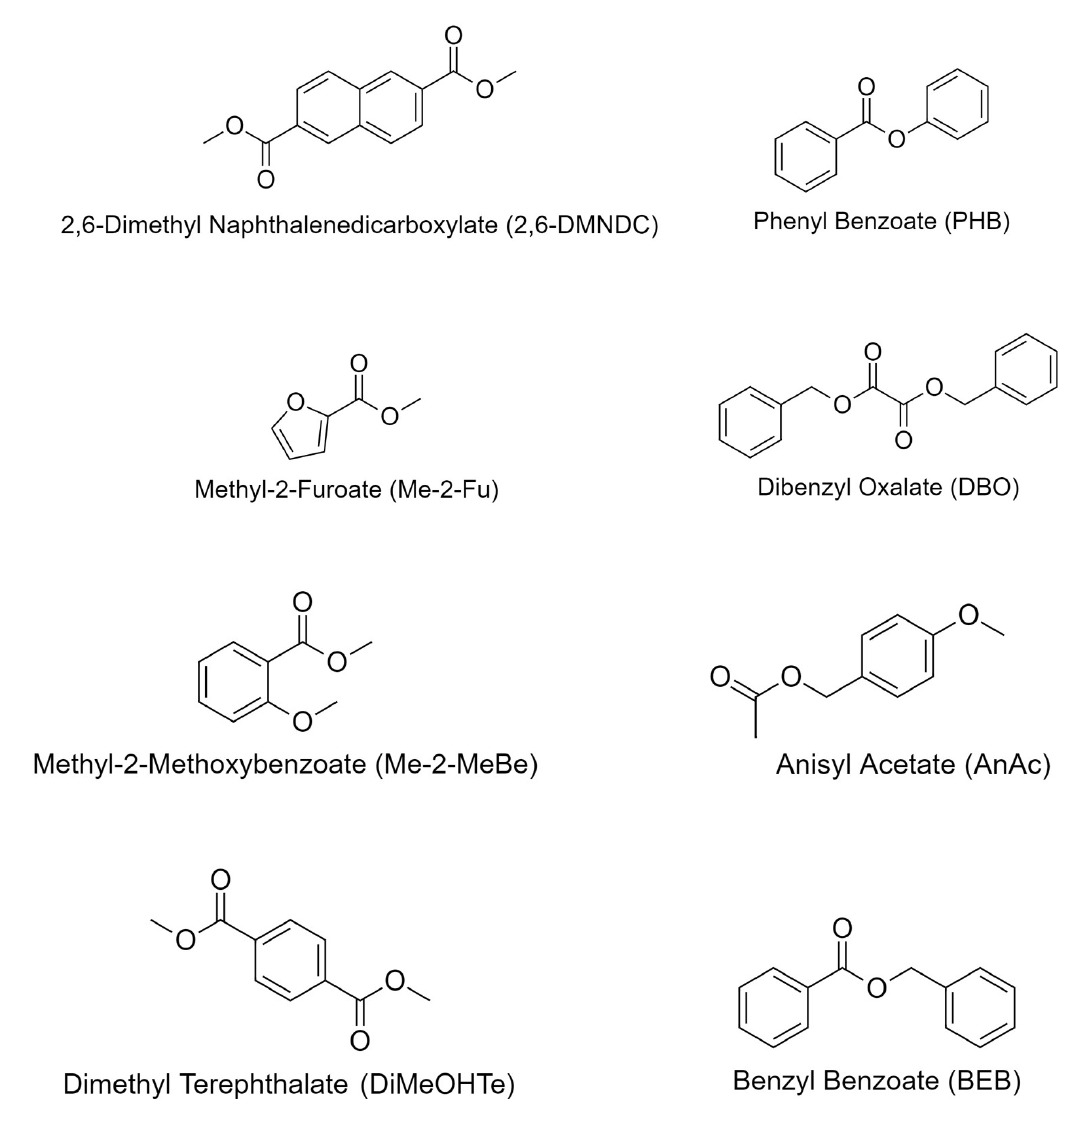
Figure 1. Chemical structures, IUPAC names and abbreviations of the aromatic esters presented in this